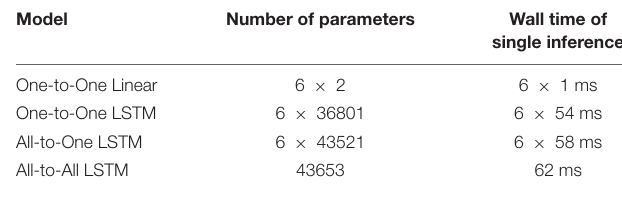
TABLE 3 | Numbers of learnable parameters and inference times of